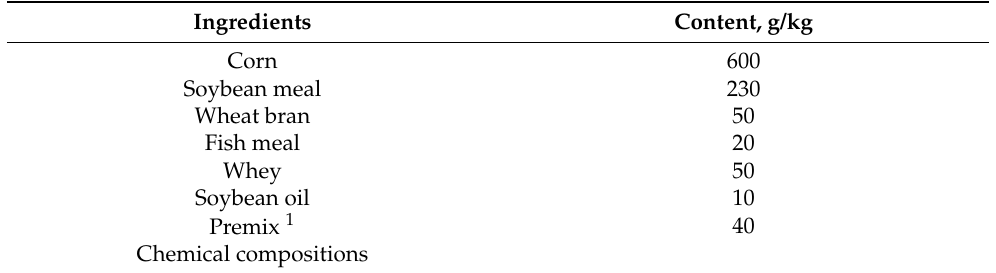
Table 1. Ingredient composition and chemical analysis of the weaning piglet